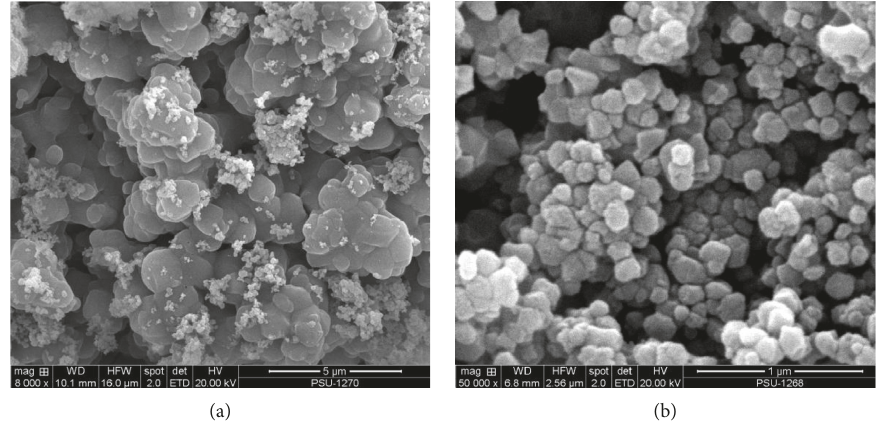
Figure 9: SEM micrographs of the (a) as-combusted and (b) as-leached product particles.